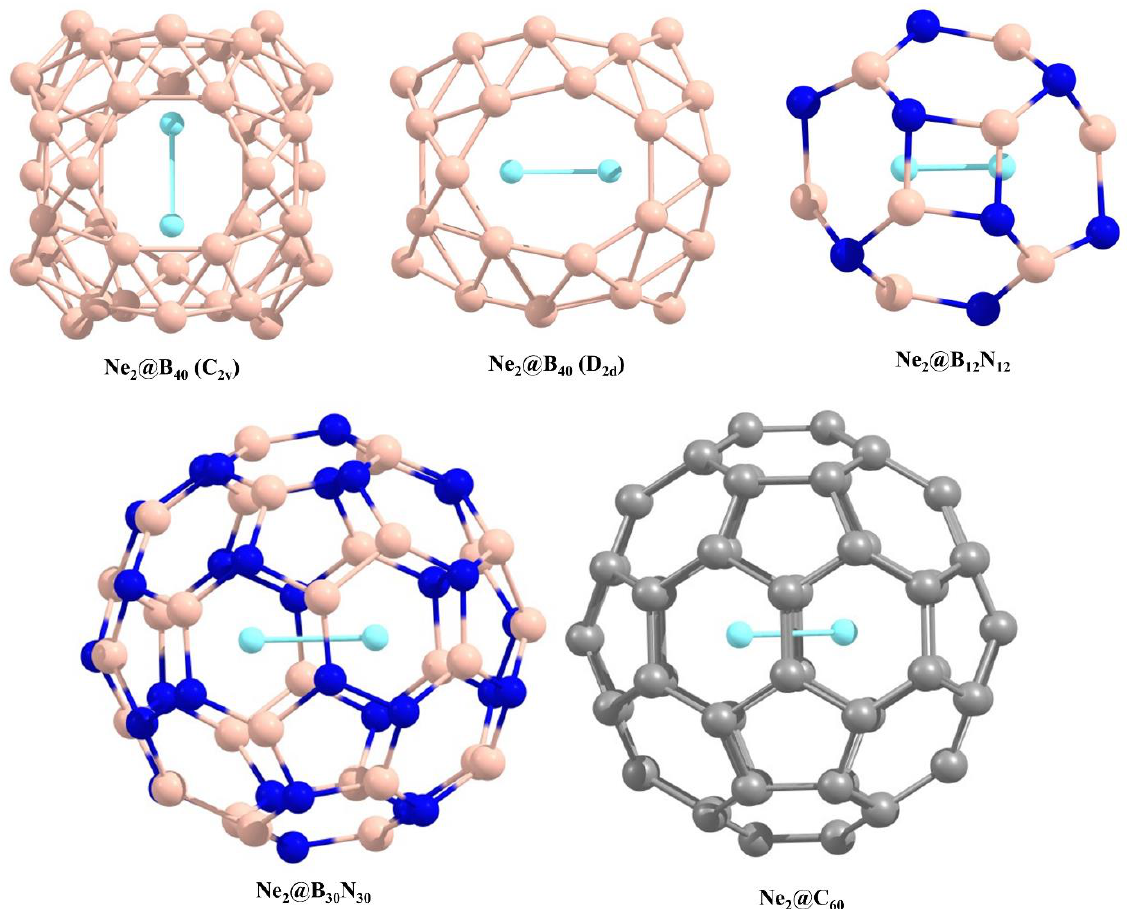
Figure 1. Optimized geometries of the Ne 2 -encapsulated cages. The boron, carbon, nitrogen, and neon atoms are indicated by light pink, grey, dark blue, and sky blue colours, respectively. neon atoms are indicated by light pink, grey, dark blue, and sky blue colours,